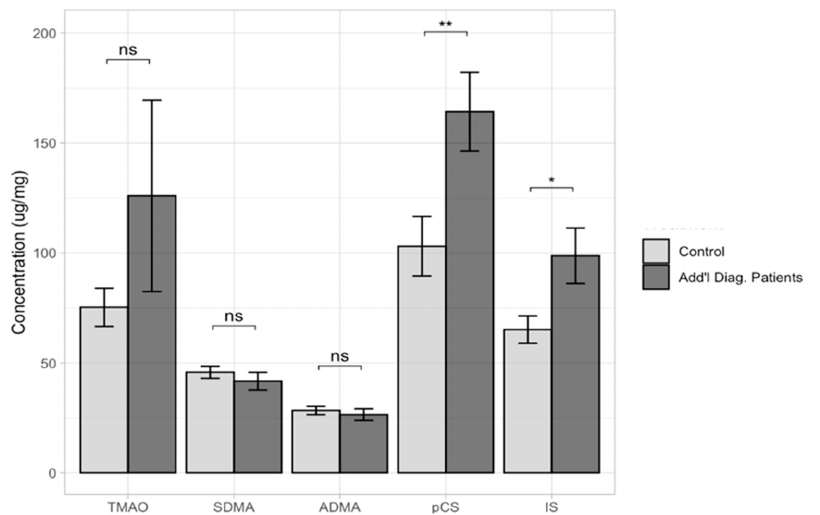
Figure 2. Determined levels of all uremic toxins in the ‘additional diagnosis’ patients’ group vs. the control group. ns—not significant difference; *—statistically significant, with p < 0.05; **—statistically significant, with p < 0.001.